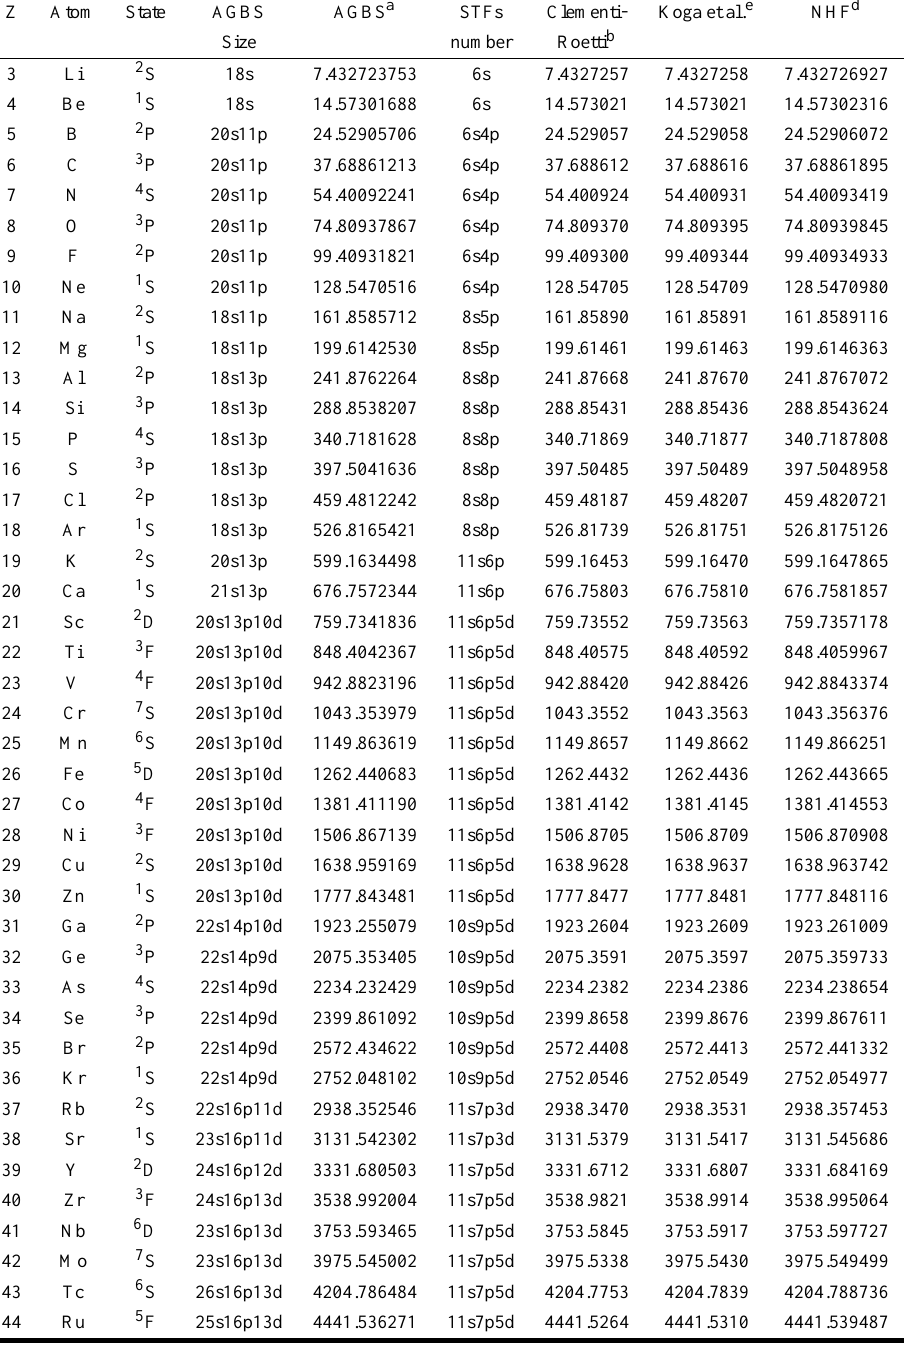
Ground state HF total energies in hartree (sign reversed) for the atoms from Li (Z=3) through Xe